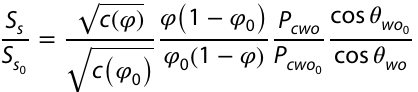
Fig. 1 Relation between the entry pore throat radius and effective pore throat radius. The dashed line shows the linear